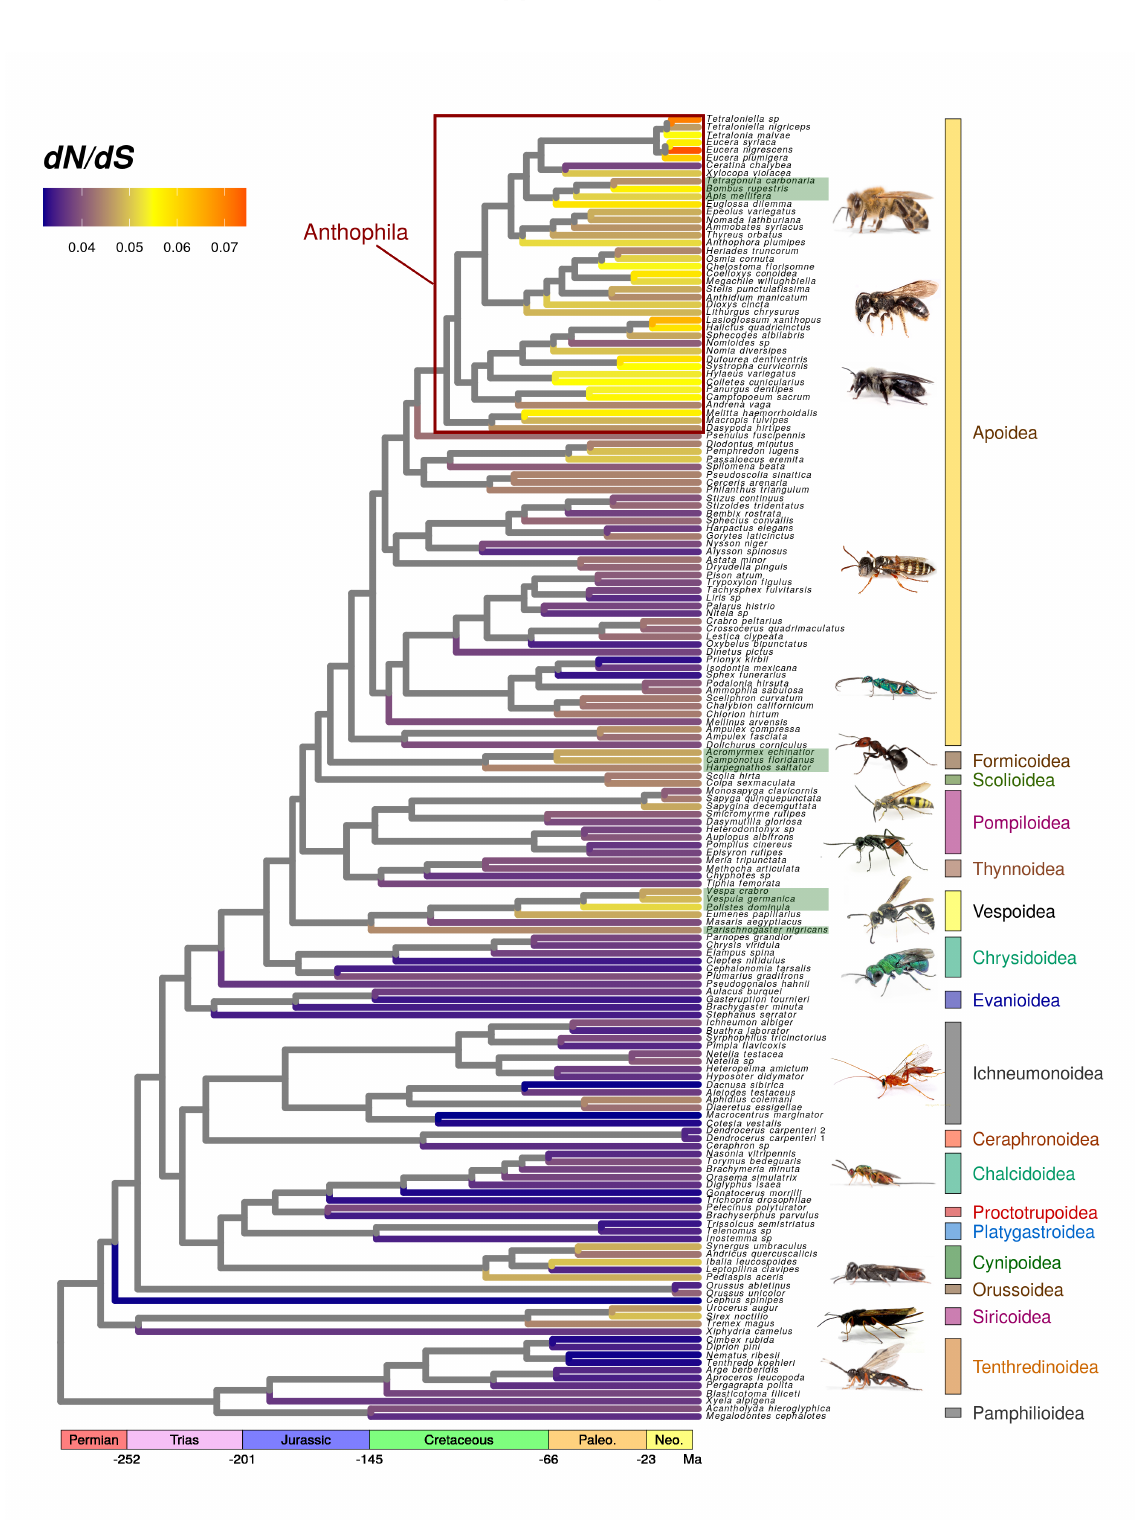
Figure S1 – Uncorrected genomic dN/dS ratios for 169 species of Hymenoptera. dN/dS ratios estimated on terminal branches using 3241 genes and GC conservative substitu- tions are represented on the chronogram inferred by Peters et al. (2017). Green rectan- gles around labels indicate eusocial